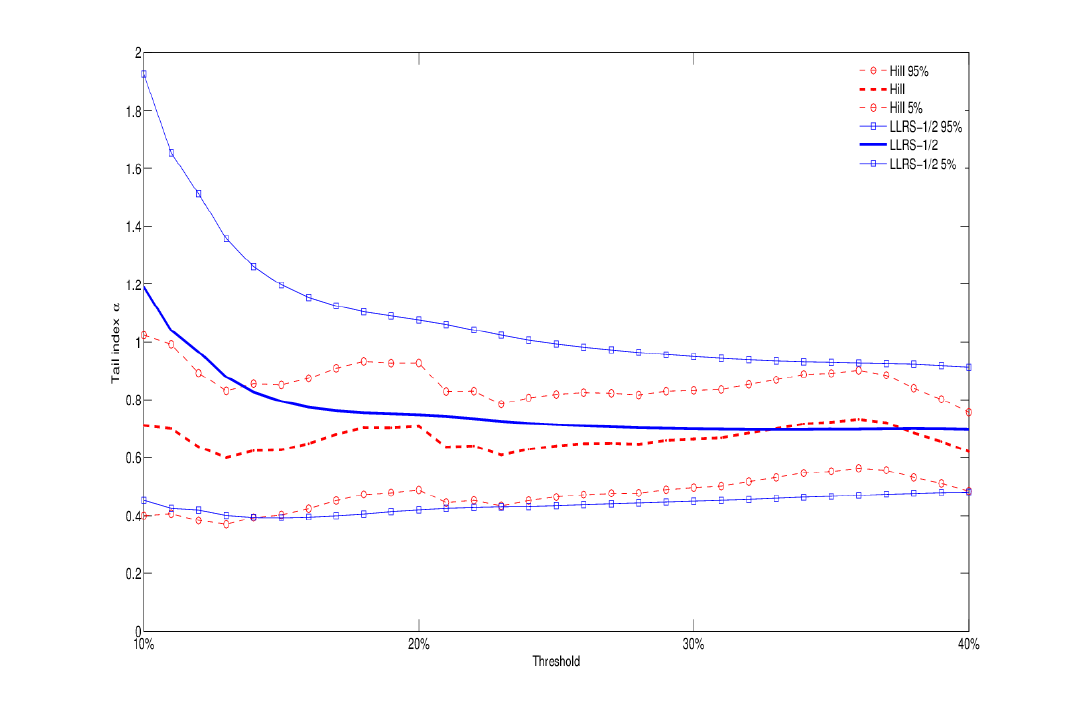
Figure 6. Occupancy level 2 types C (chemicals), J (metals), and M (mines) aggregated: tail index estimation (both Hill and LLRS-1/2 regression methods), with 90% confidence